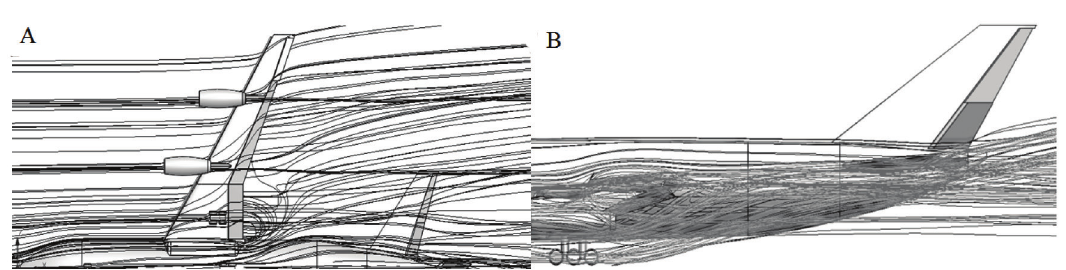
Figure 7. Flow streamlines and interference behind the wing-tailing edge at V l = 77.87 m/s viewed from: A – upper view on Oxz plane showing horizontal flow drifting; B – side view on Oxy plane showing vertical flow drifting